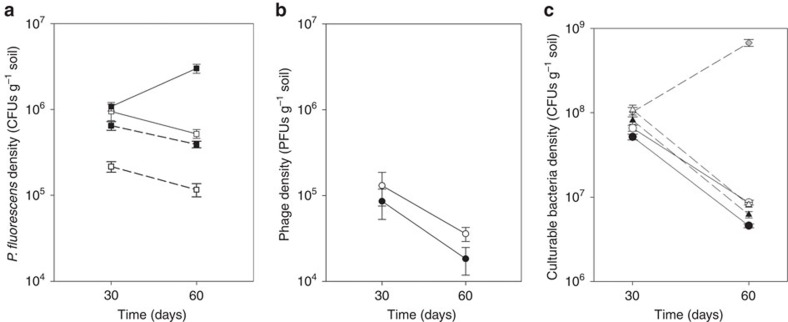
Bacterial population densities in the natural microbial community.(a) Mean densities (±s.e.m.) of the six replicates of ancestral (white square) and locally adapted (black square) P. fluorescens SBW25 (CFUs g−1 soil) in the presence of the natural microbial community (solid line) and the presence of phages (dash line). (b) Mean densities (±s.e.m.) of phage SBW25φ2 (plaque-forming units (PFUs)  g−1 soil) populations. (c) Mean densities (±s.e.m.) of the six replicates of the culturable bacteria (CFUs g−1 soil) in the natural microbial community with no SBW25 (grey diamond), ancestral SBW25 (white circle, white triangle) and locally adapted SBW25 (black circle, black triangle) in the absence (solid line) and presence (dashed line) of phages.